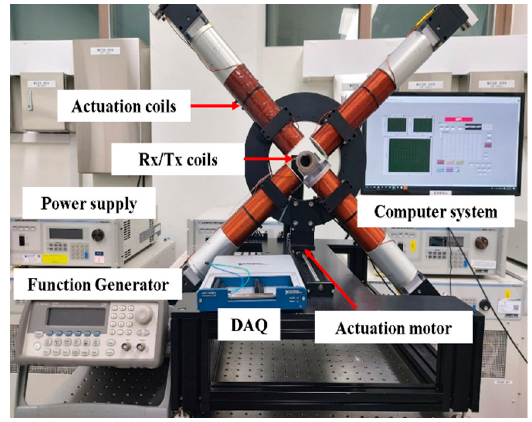
Figure 4. The four-coil scanning system. Table 2. Detailed parameters of the proposed coil system.